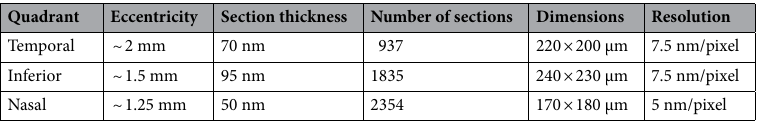
Table 1. Three volumes from central macaque retina were analyzed. Details about the location, section thickness and resolution are